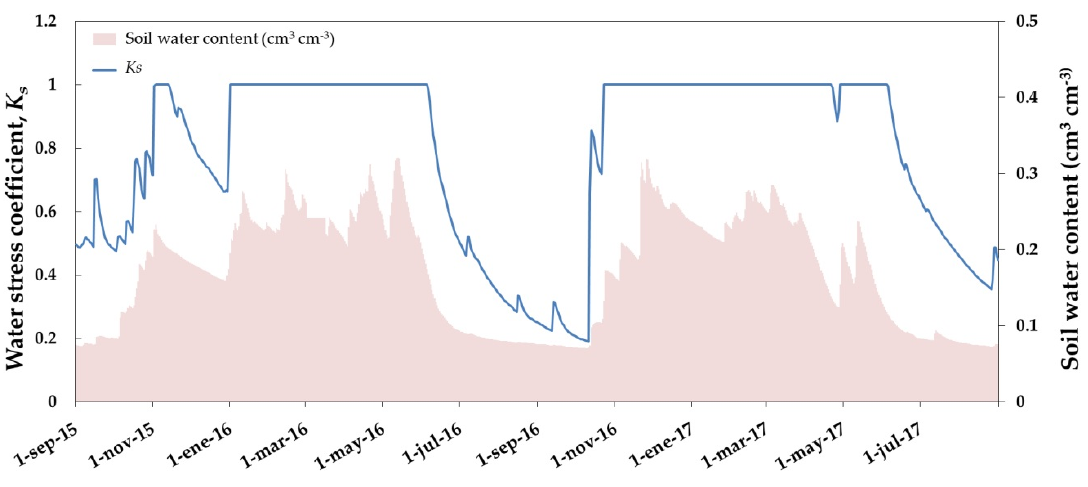
Figure 10. Daily evolution of water stress coefficient, K s, computed by the VI-ETo method and soil water content over the open grassland.